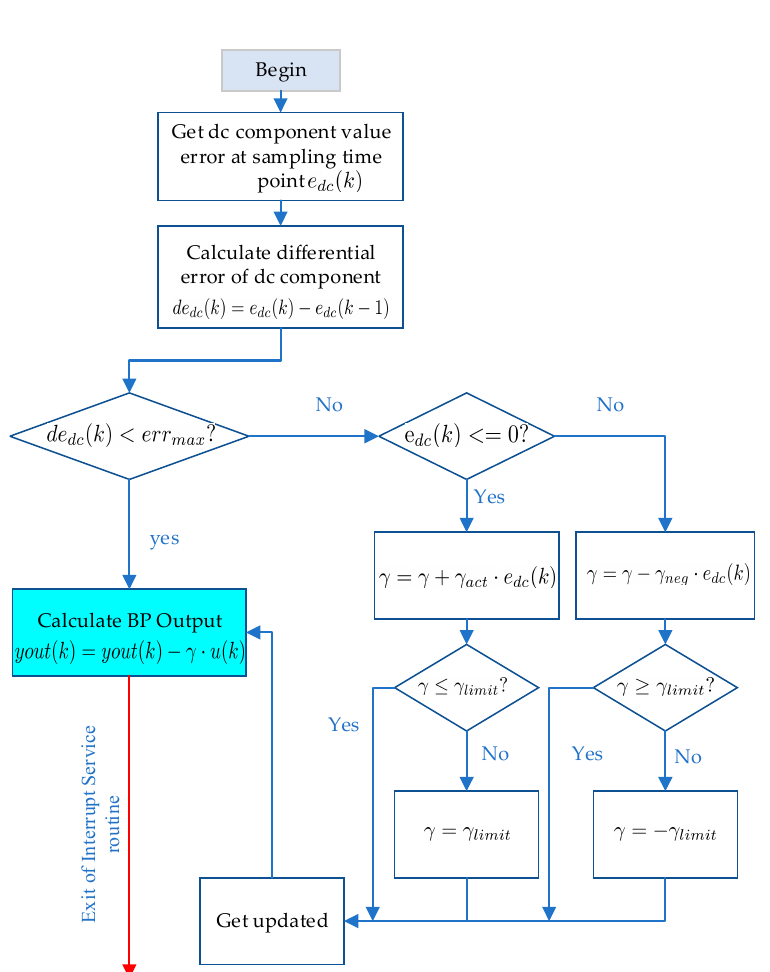
Figure 5. Implementation flowchart of adaptive speed learning coefficient regulation method for BP neural network.